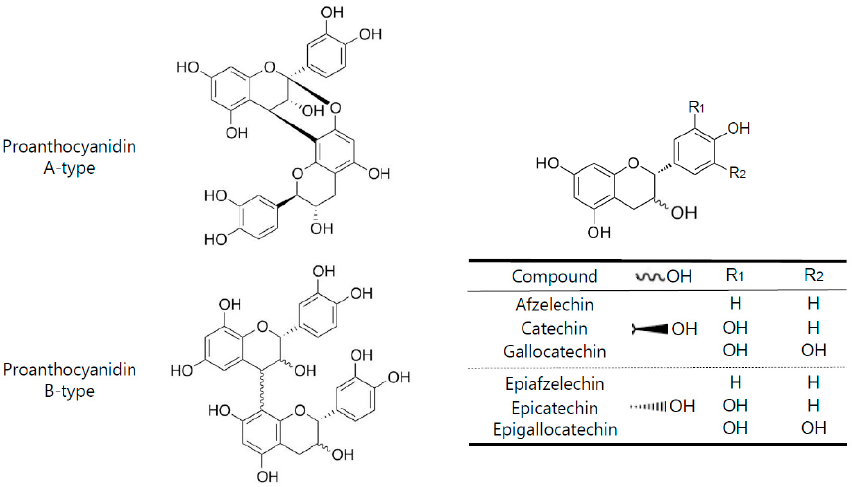
Figure 1. Basic chemical features of A-and B-type proanthocyanidinsand their monomeric